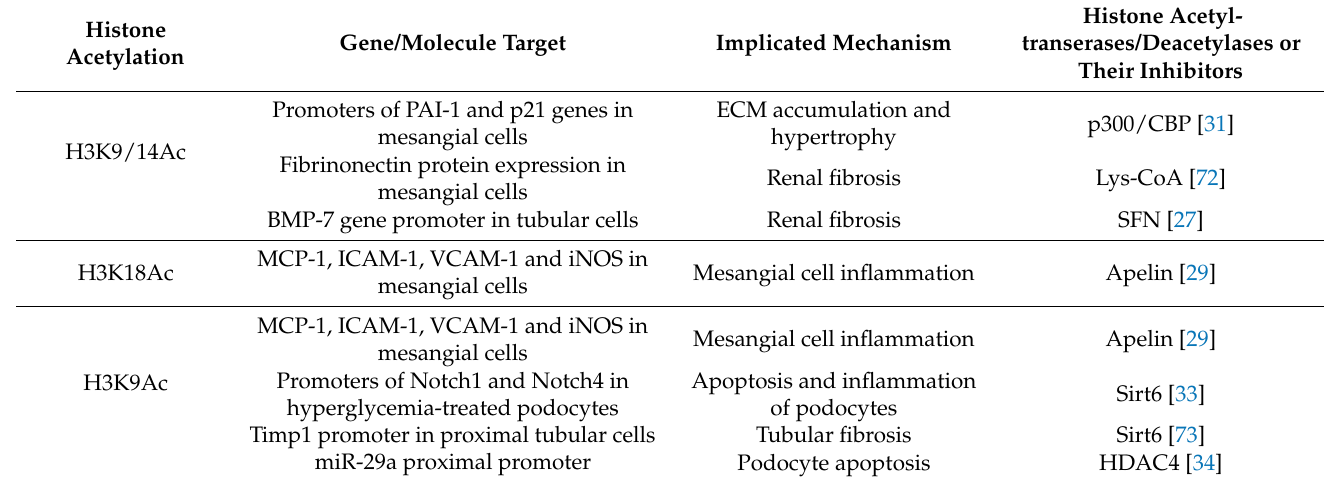
Table 3. Effects of histone acetylation on the pathogenesis of diabetic kidney